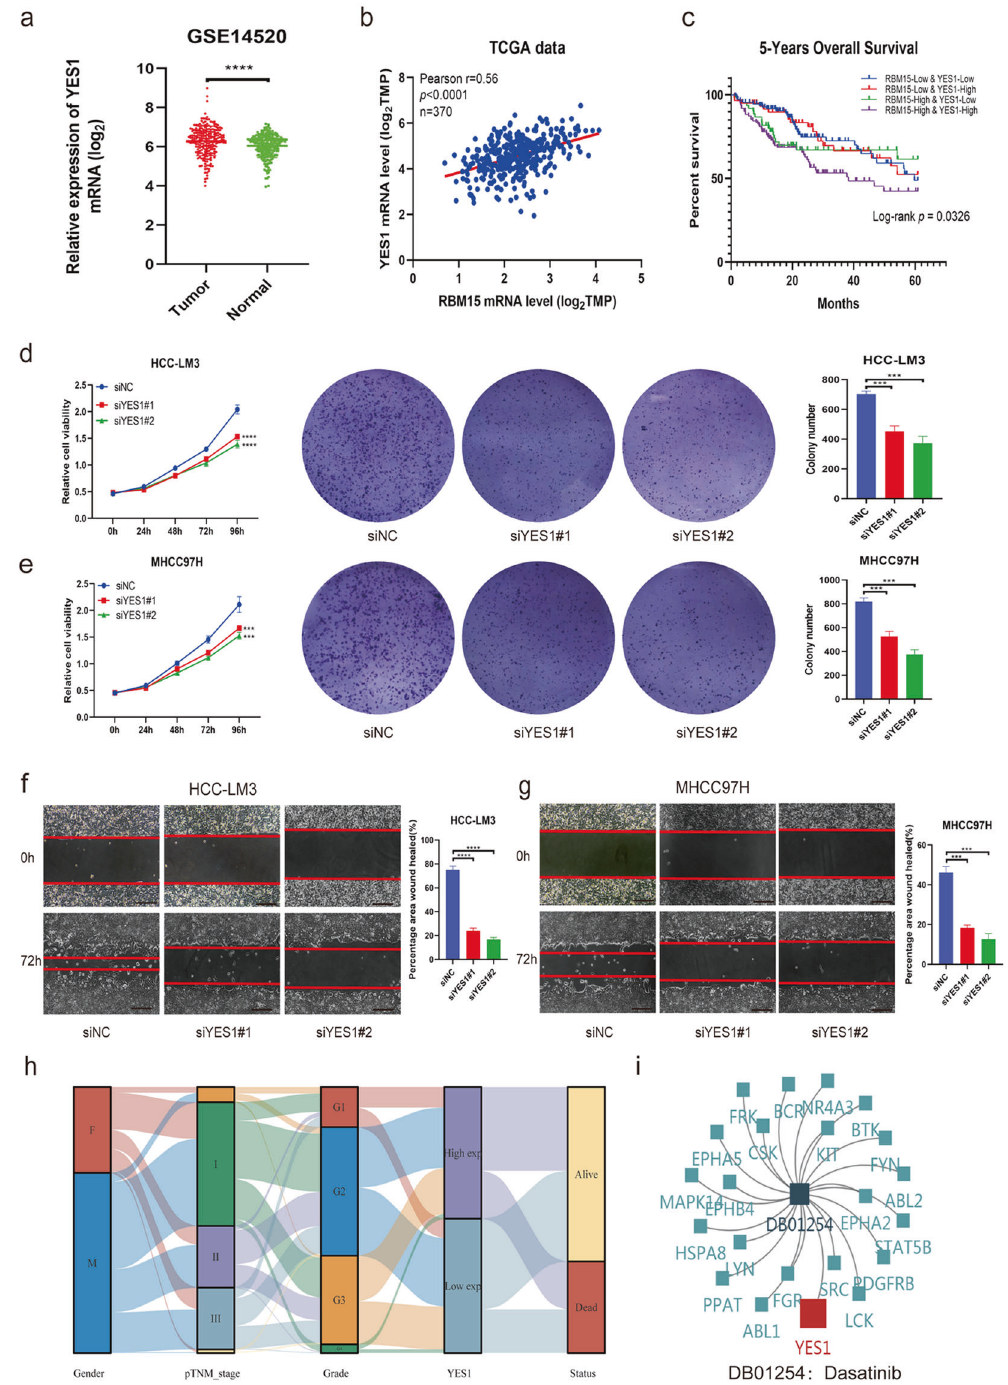
Fig. 6 YES1 promotes tumor growth of HCC cell in vitro. a The expression of YES1 mRNA was compared between tumors and normal tissues based on GEO database (GSE14520) (**** p < 0.0001; t test); b TCGA data analysis showed a positive correlation of RBM15 and YES1 based on mRNA expression; c overall survival analysis according to the co-expression of RBM15 and YES1 in TCGA data. Both high expression of RBM15 and YES1 indicated the worst prognosis; d , e negative control or siRNA (si-YES1#1 and #2) was transfected into HCC-LM3 ( d ) and MHCC97H ( e ), respectively. The proliferation capacities of HCC cells were detected by CCK-8 and colony-formation assays. Colony numbers were quanti fi ed by bar charts (*** p < 0.001, **** p < 0.0001; two-way ANOVA and t test); f , g wound-healing assays were performed to compare the migration capabilities of HCC-LM3 ( f ) and MHCC97H ( g ) cells (scale bars, 200 μ m). The percentage of healed area was quanti fi ed by bar charts (*** p < 0.001, **** p < 0.0001; t test); h Sankey diagram showed the inter-relation between the YES1 expression and other clinical characteristics; i dasatinib was a potential drug for patients with YES1 overexpression or other relevant targets. The data are presented as mean ± SD.